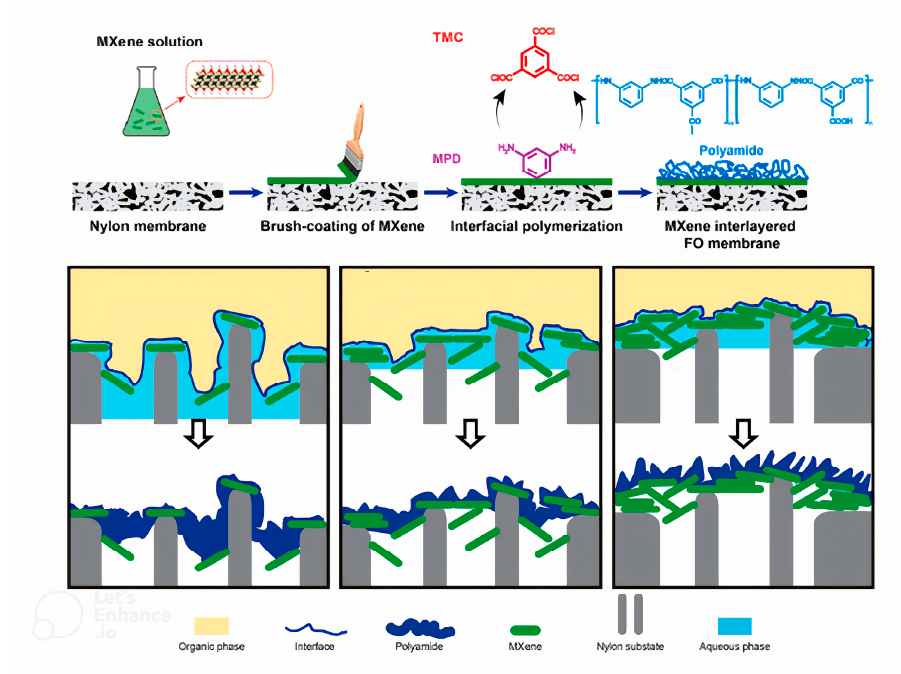
Figure 13. Polyamide membrane hybridized by Ti 3 C 2 T x [227].